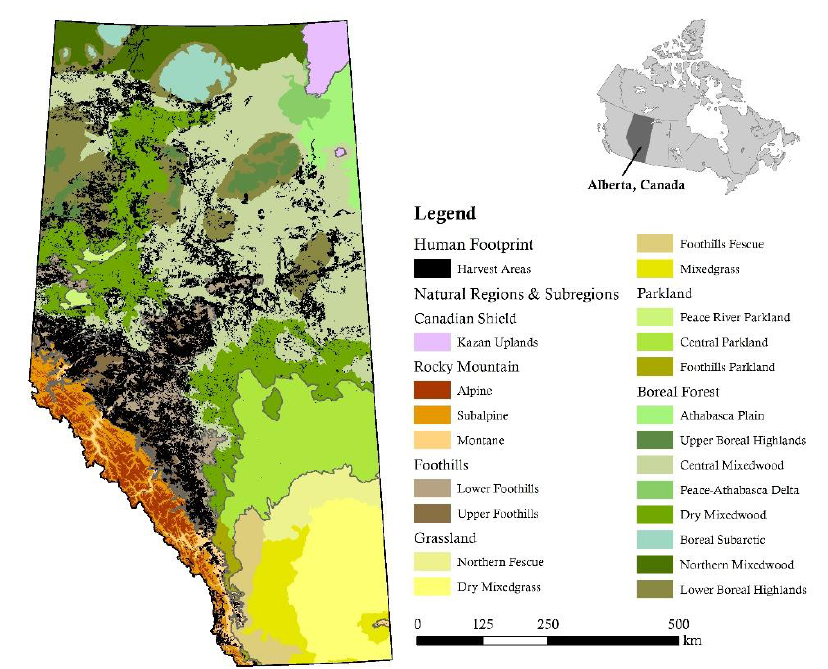
Figure 1. Study area map showing forest harvest areas distributed across the Natural Regions and Subregions [48] of Alberta, Canada.